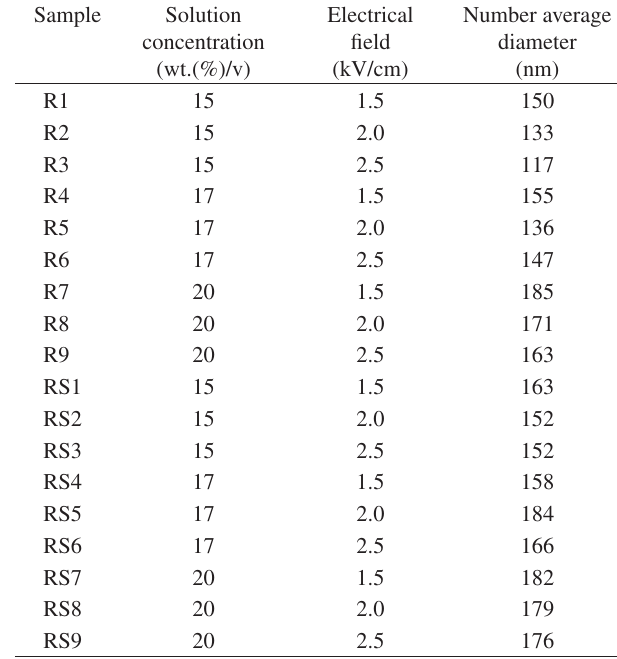
Table 4. Electrospinning conditions of sample